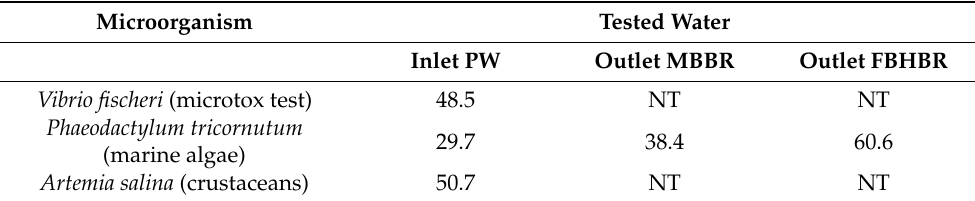
Table 4. Ecotoxicity measurements of inlet water (TDS = 8 g · L − 1 ) and outlet water (MBBR and FBHBR) expressed as EC50 (%) (NT refers as